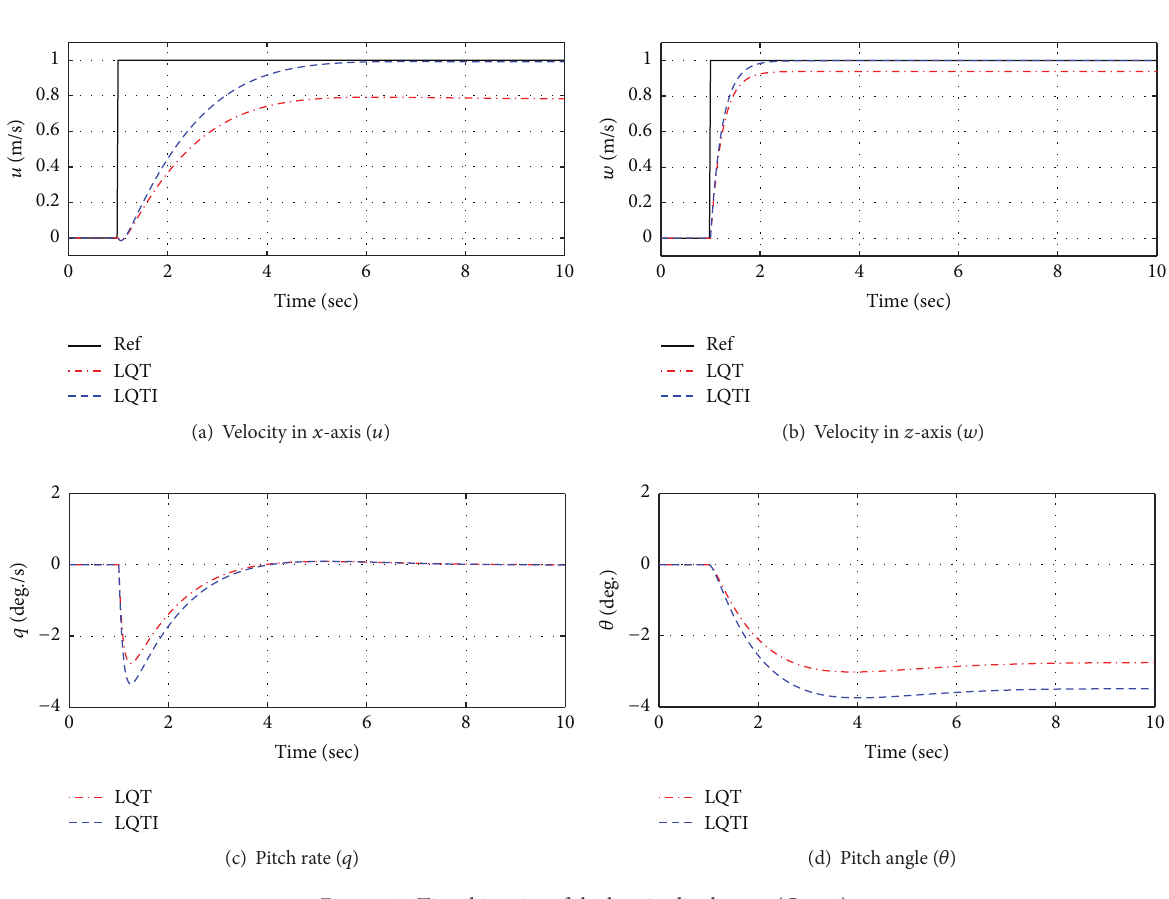
Figure 11: Time histories of the longitudinal states (Case 1).